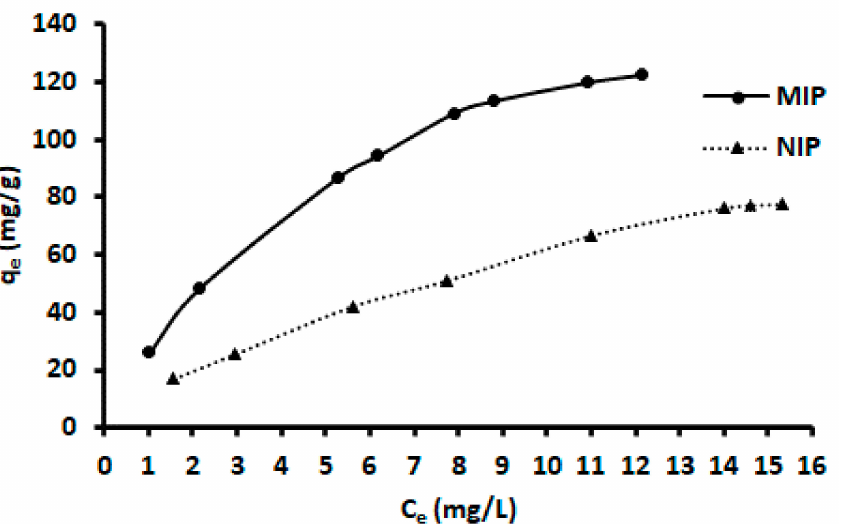
Figure 10. Adsorption isotherm for MIP (circle) and NIP (triangle). Experimental parameters: initial concentration, 1–20 mg/L, the mass of adsorbent, 23 mg; contact time, 12 min, sample pH; sample volume, 100